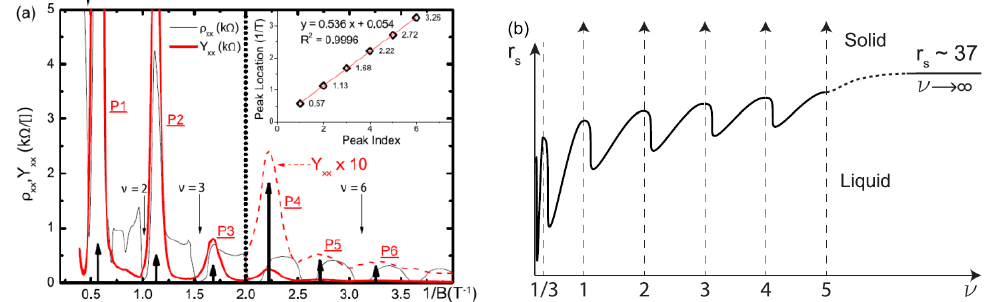
Figure 2. ( a ) Observation of multiple RIPs between Landau-level filling factors 1, 2, 3 and 4 in a dilute 2D hole system in GaAs with r s ~20. ( b ) The modified phase diagram with multiple RIPs. Figure is taken from Reference [12].